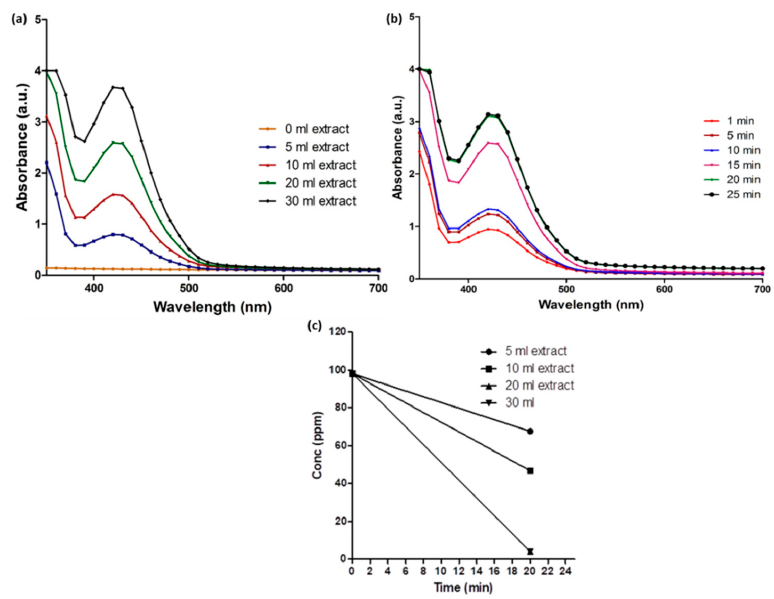
Figure 2. UV-Visible spectrum of Coptidis rhizome -mediated biosynthesized silver nanoparticles. ( a )